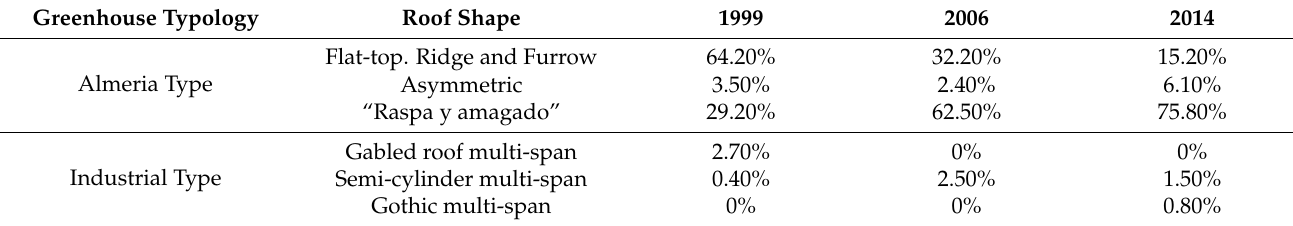
Table 2. Evolution of typology (% of each type with respect to the total) of greenhouses in the Poniente region. Authors’ elaboration from source